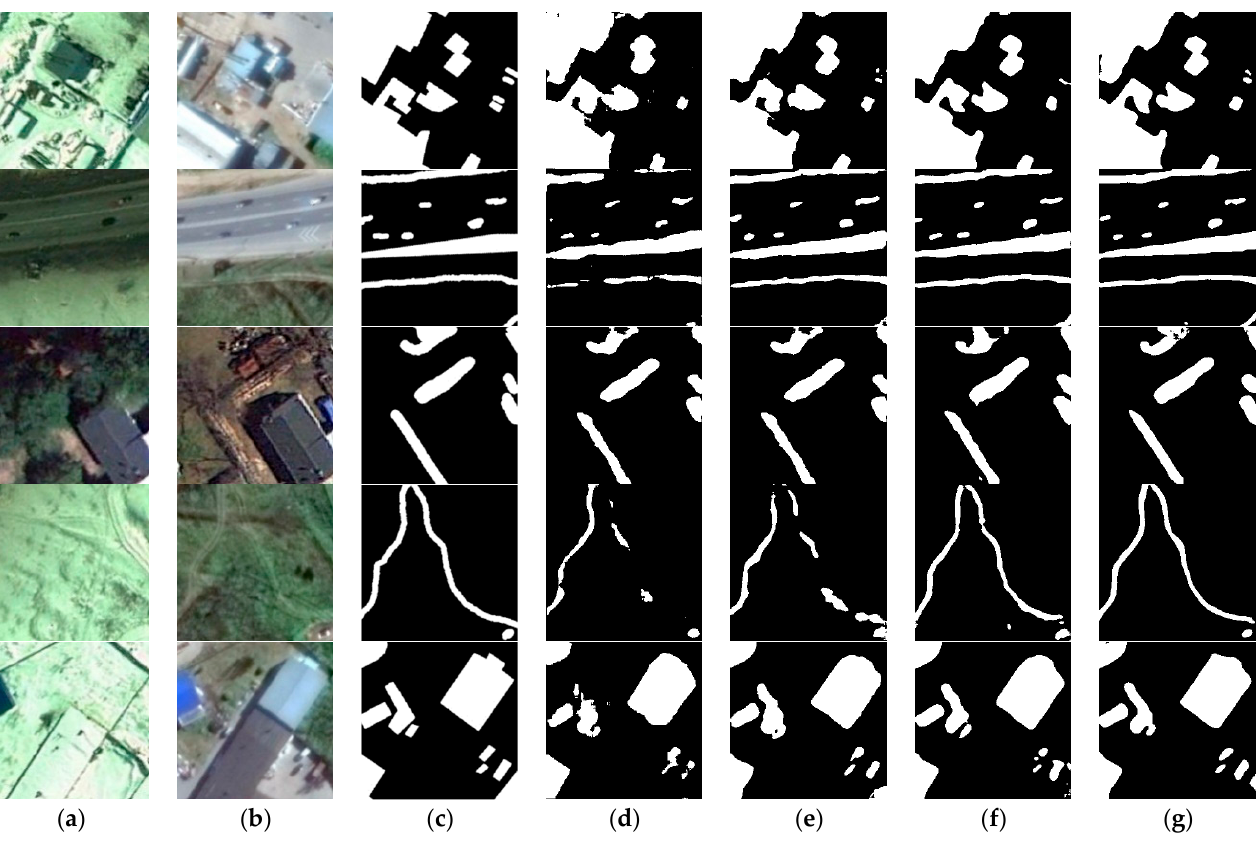
Figure 5. Visual comparison results of ablation experiments: ( a ) T1 image, ( b ) T2 image, ( c ) ground truth, ( d ) Siamese UNet, ( e ) MRA-SNet without the Multi-Res block, ( f ) MRA-SNet without the Attention Gates module, ( g ) MRA-SNet. The changed areas are marked by white, and the unchanged areas are marked by black.